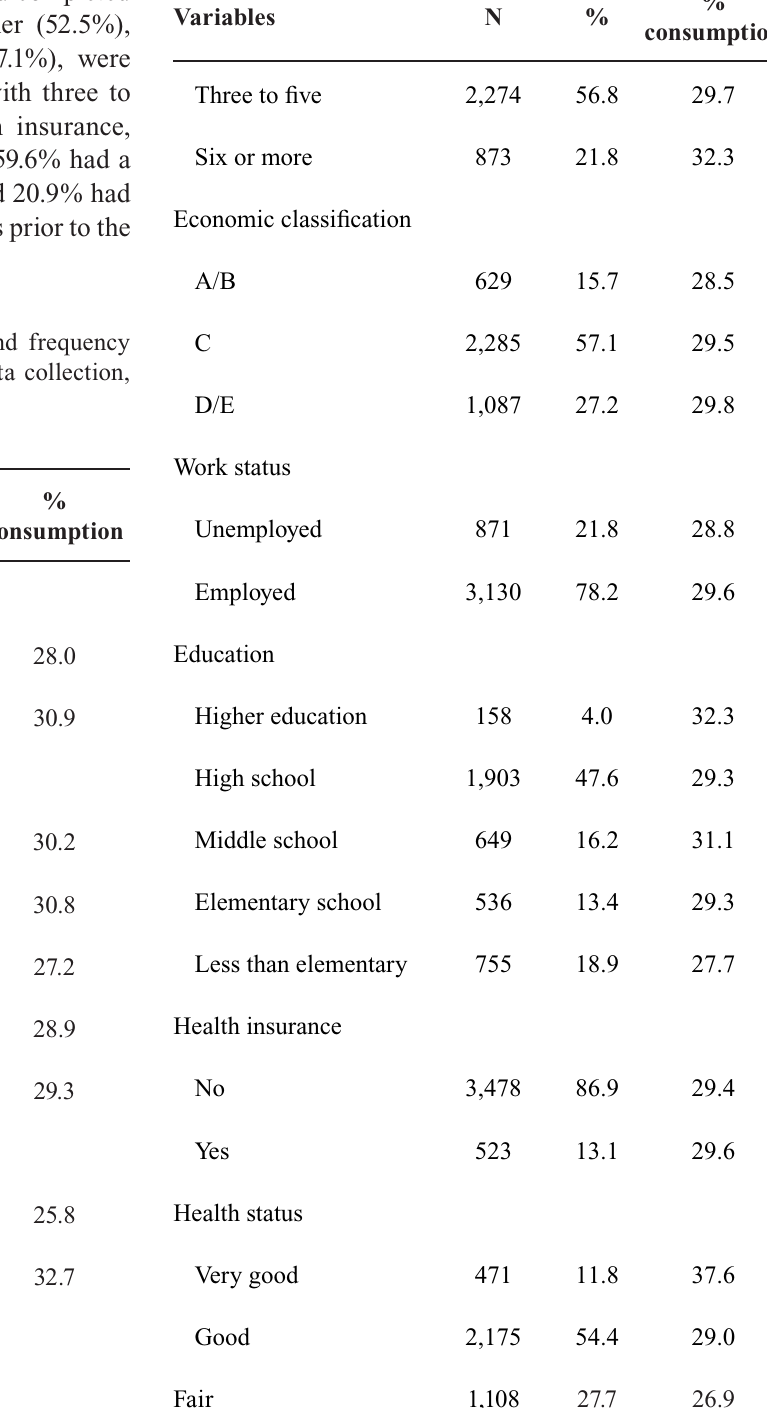
TABLE I - Characteristics of the population and frequency of use of medicines in the 15 days prior to data collection, Manaus Metropolitan Region, 2015